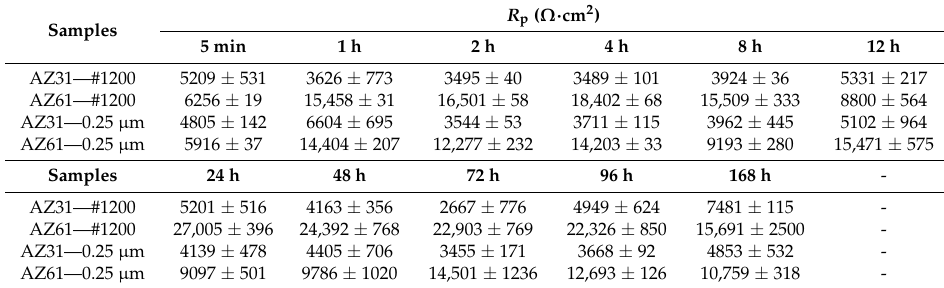
Figure 5. Nyquist plots of ground (#1200) and polished (0.25 µm) samples of AZ31 and AZ61 magnesium alloys obtained in enriched HBSS+ (with Mg 2+ and Ca 2+ ions): ( a ) AZ31—0.25 µm, ( b ) AZ31—#1200, ( c ) AZ61—0.25 µ m and ( d ) AZ61—#1200. Table 5. Polarization resistance values obtained from EIS (electrochemical impedance spectroscopy) measurements performed in enriched HBSS+ (with Mg 2+ and Ca 2+ ions).